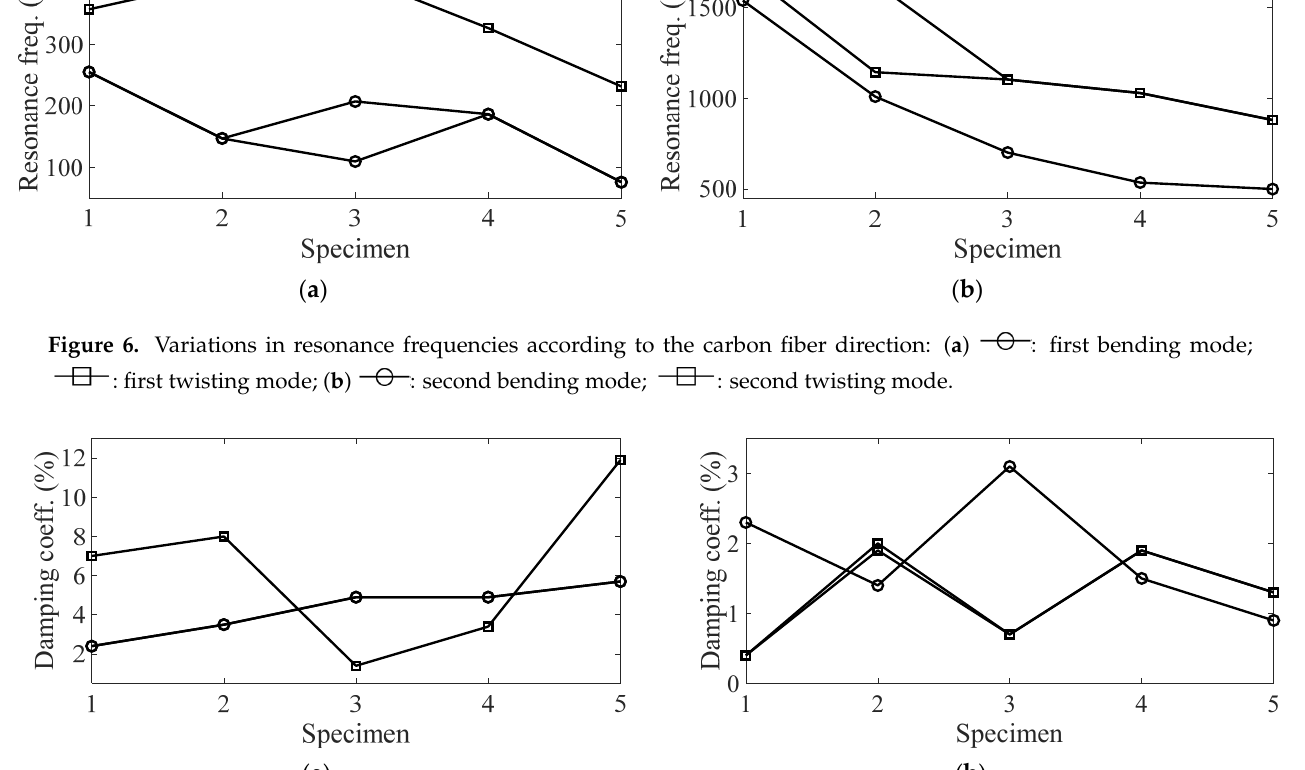
Figure 7. Variations in damping coefficients according to the carbon fiber direction: ( a )